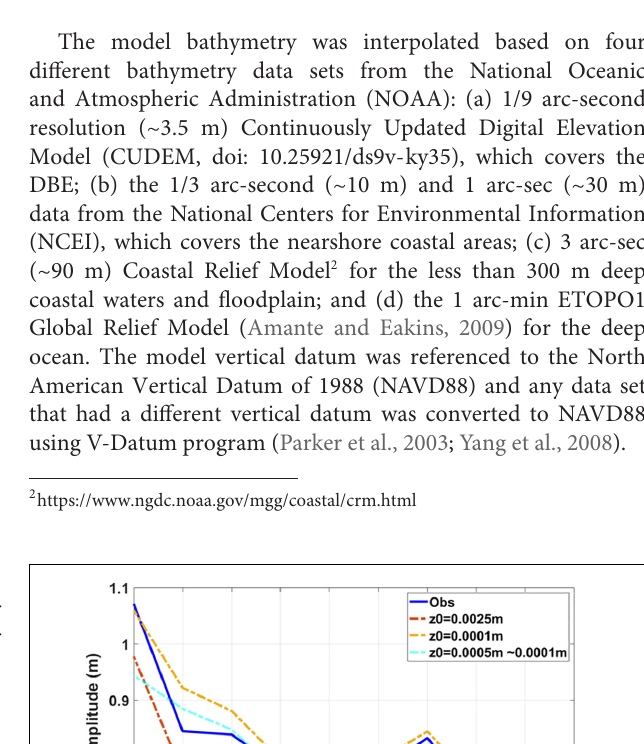
FIGURE 2 | FVCOM model grid (white line) with color contours showing the mesh resolution (A) the whole model domain (B) zoom-in of the upper channel near Philadelphia (C) lower bay near estuary mouth.